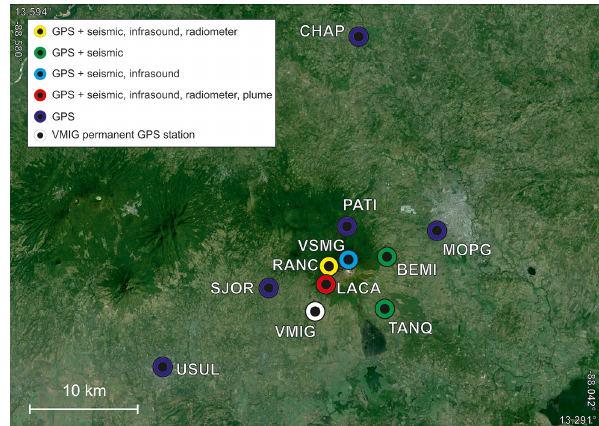
Figure 6. Map of the multiparametric network installed in Jan- uary